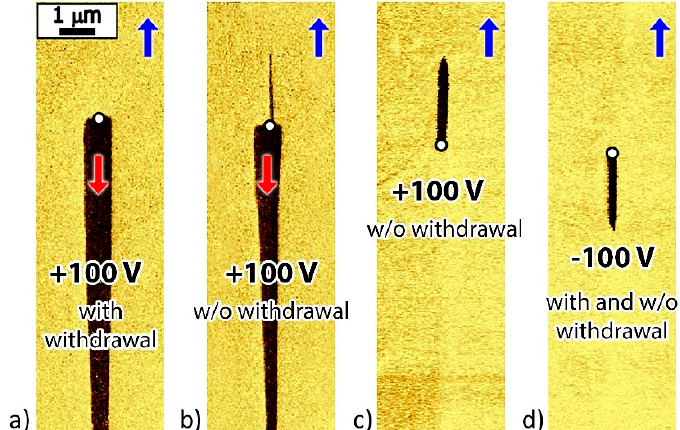
Figure 9. PFM images of the domains written by local polarization reversal: By a positive pulse ( a ) with probe withdrawal, ( b , c ) without probe withdrawal, and ( d ) negative pulse with and without probe withdrawal. Red and blue arrows indicate the spontaneous polarization directions.